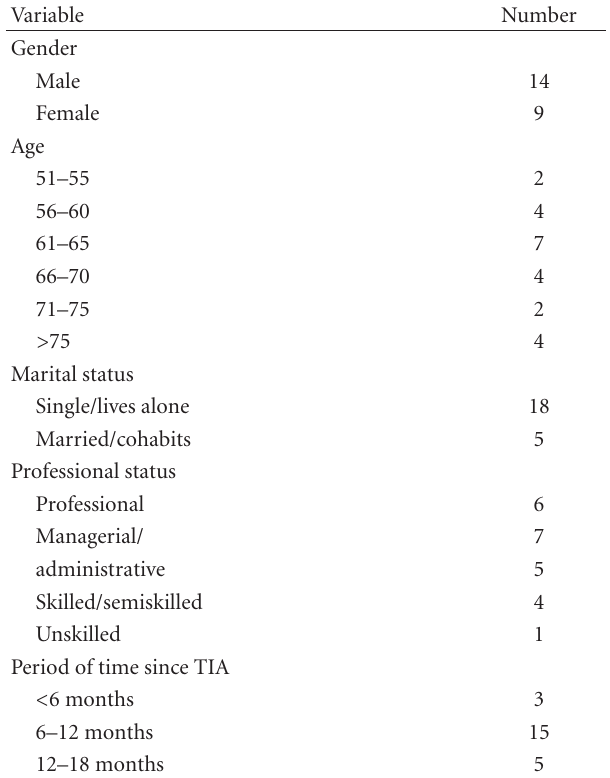
Table 2: Sample characteristics ( n = 23).